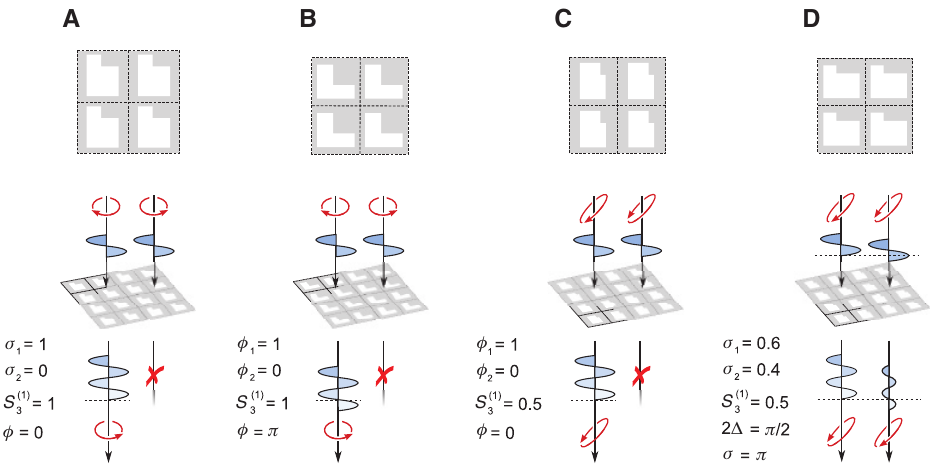
Figure 6: Example of wave operations achievable with the minimal metasurface: (A) circular polarizer, (B) circular polarizer plus phase delay, (C) elliptical polarizer, (D) elliptical diattenuator plus phase